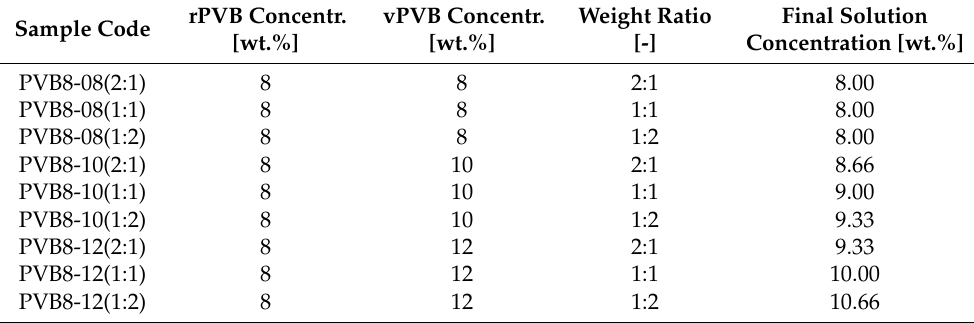
Table 2. Prepared bPVB made of rPVB and vPVB ethanol